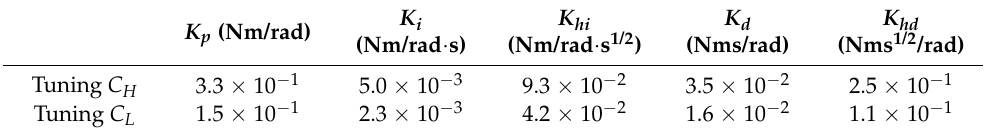
Table 1. PII 1/2 DD 1/2 control parameters.